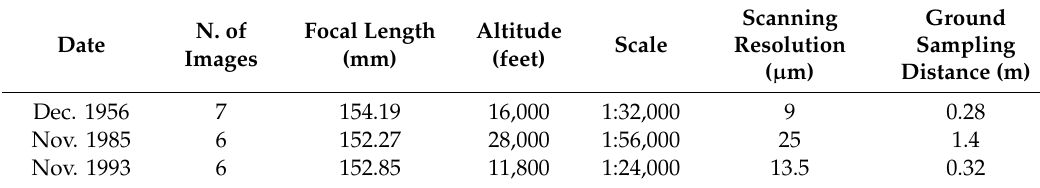
Table 1. Characteristics of the historical aerial